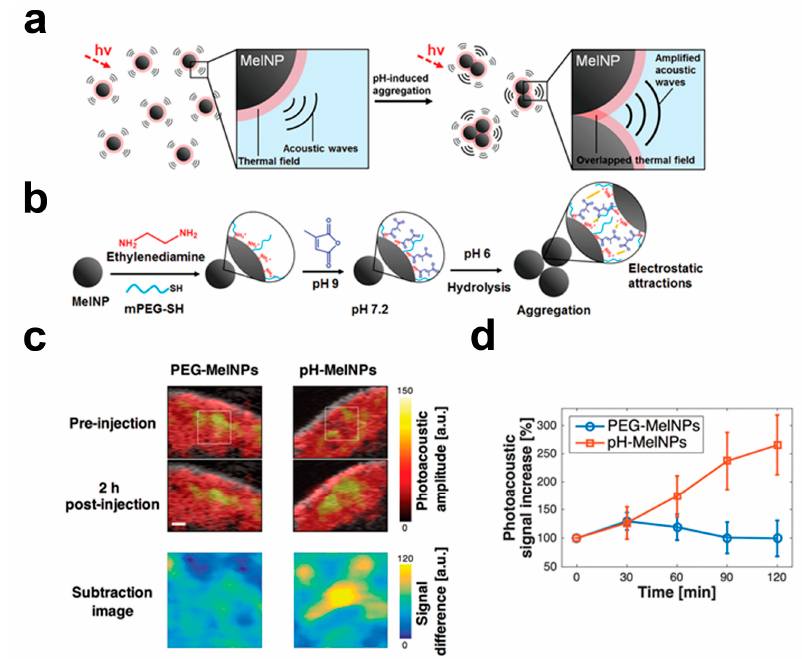
Figure 2. ( a ) Schematic illustration of the proposed aggregation-induced amplification of the OA signal from melanin nanoparticles (MelNP) upon laser irradiation (hv, dashed arrow); ( b ) the surface modification of the bare melanin nanoparticles with citraconic amide results in the aggregation, under mildly acidic conditions (pH-MelNP); ( c ) combined ultrasound (US, in gray) and optoacoustic (OA, in red and yellow) images of B16 melanoma in living mice before and after the intravenous injections (concentration: 1 mg/mL, volume: 0.2 mL) of the PEG-MelNP (left column images) and the pH-responsive melanin-nanoparticles (right column images). The difference image was obtained by subtracting OA signals in the tumor site (a white box) of the pre-injection image from those in the post-injection image; ( d ) a change in the difference of OA signal intensity between the pre- and the post-injection images acquired at 30, 60, 90, and 120 min. Reprinted with permission from reference [32], Copyright 2016, Royal Society of Chemistry.